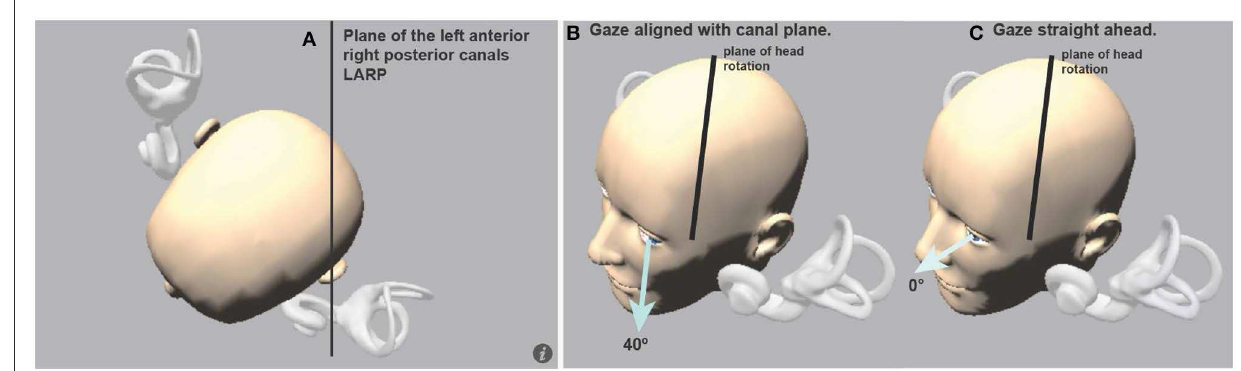
FIGURE10 (A) View looking down on a schematic head with enlarged semicircular canals to show the approximate planes of the vertical canals. (B) The optimal horizontal eye position for using vHIT to measure vertical canal function: it is gaze aligned with the canal plane under test, in this case, LARP stimuli are delivered and gaze should be along the LARP plane. (C) If gaze is straight ahead (0 ◦ ), the prediction is that the vertical eye velocity component becomes much smaller (Figure 11) [Reproduced from McGarvie et al. (36) with